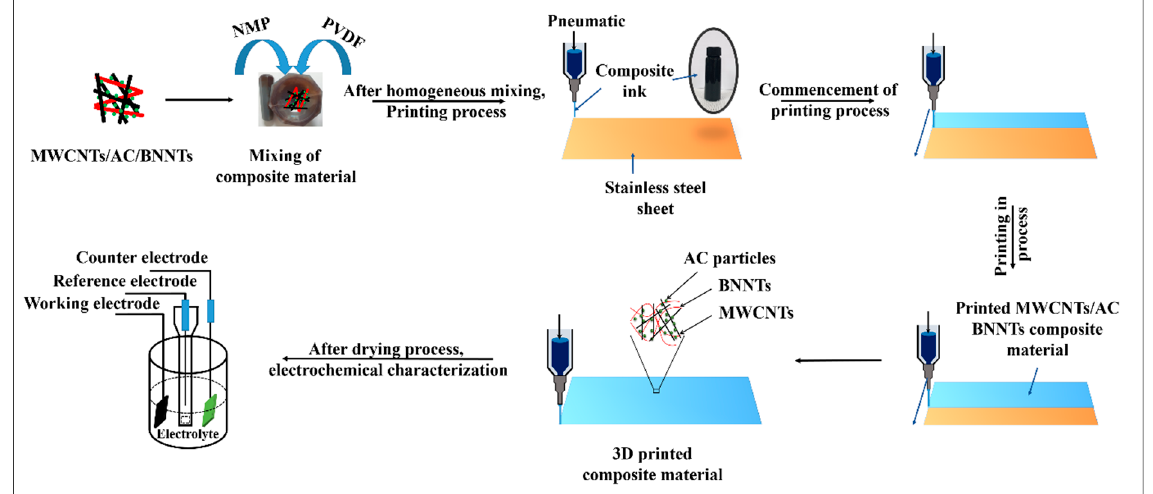
Figure 1. Schematic diagram illustrating the synthesis steps involved in the fabrication of the printed multiwalled carbon nanotubes/activated carbon/boron nitride nanotubes (MWCNTs/AC/BNNTs) ternary composite electrode material.